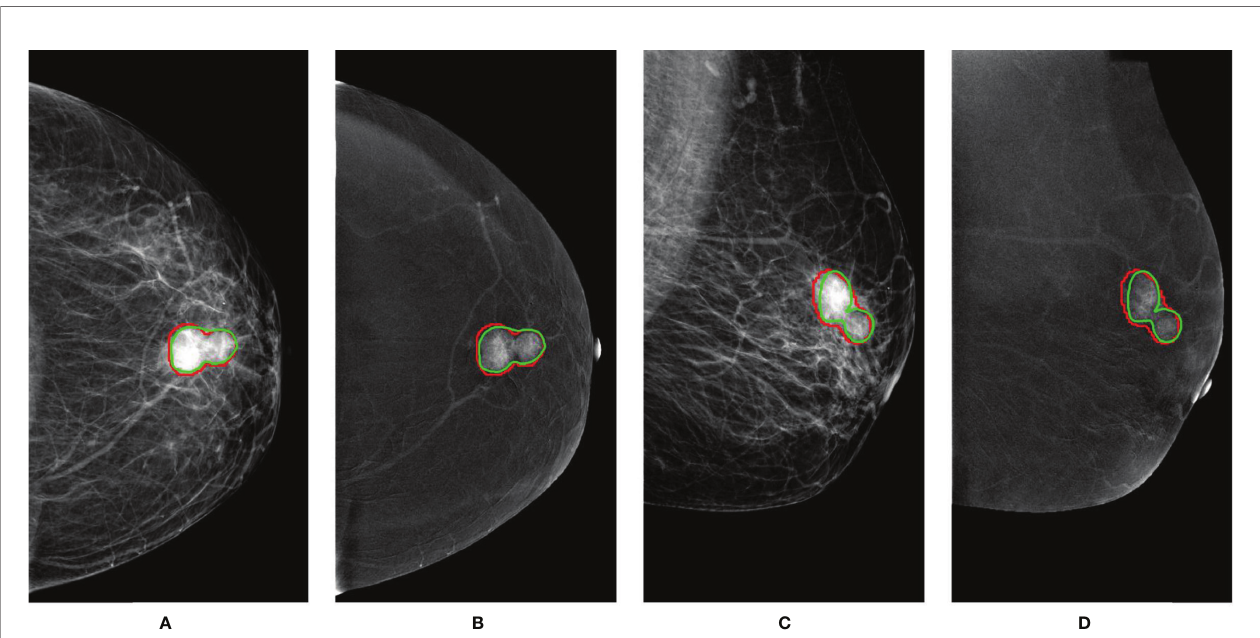
FIGURE 4 | An example of breast tumor segmentation. The green lines are automatic segmentation results. The red lines are manual delineations of tumors. For images with CC views (A, B) , the Dice score is 0.91. For images with MLO views (C, D) , the Dice score is 0.85. CC, craniocaudal; MLO, mediolateral oblique.